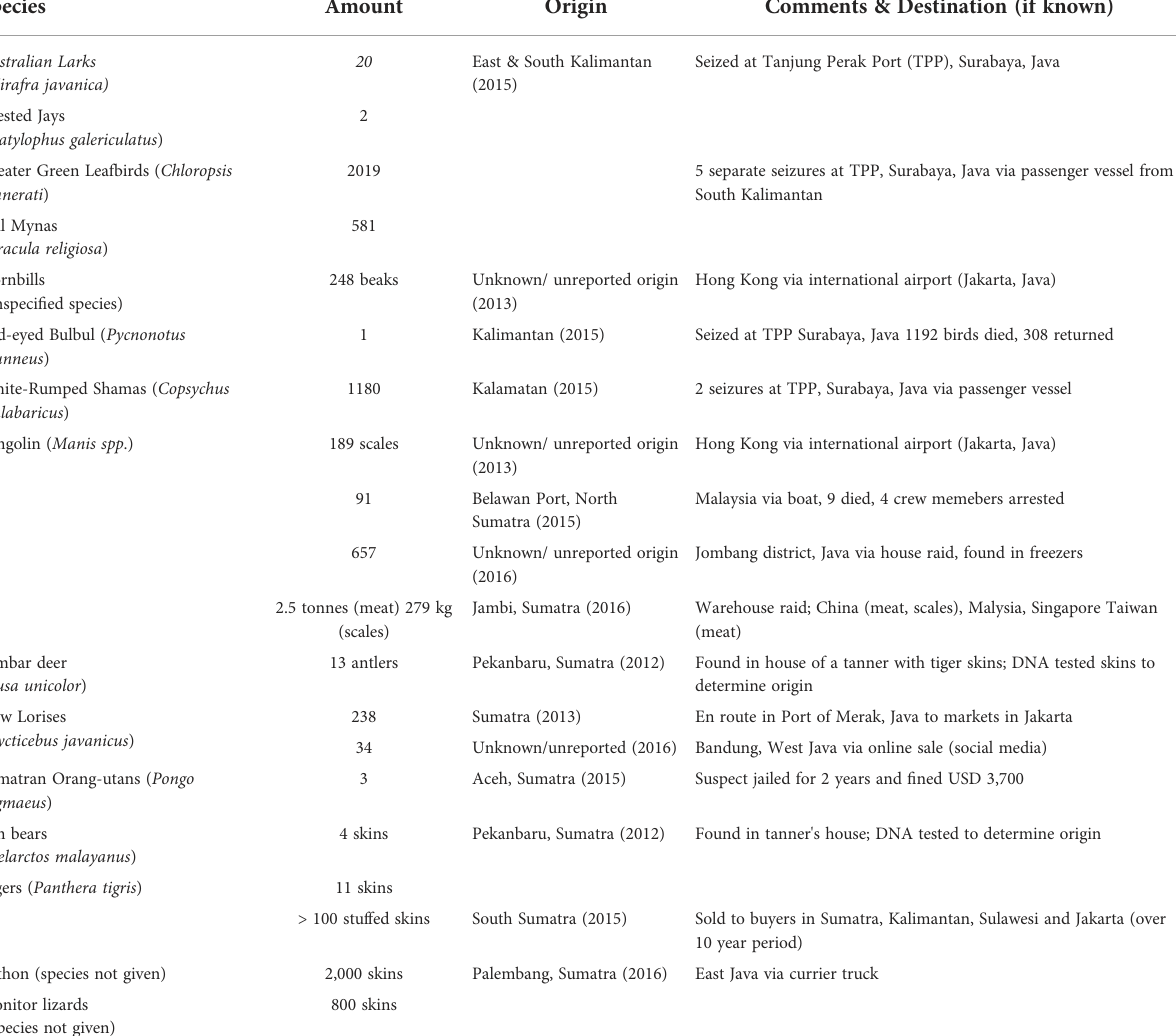
TABLE 3 Seizures of terrestrial wildlife species and products found in Sumatra, Indonesia from 2012-2016 (Source TRAFFIC Bulletin Volumes 25- 29: www.traf fi c.org).